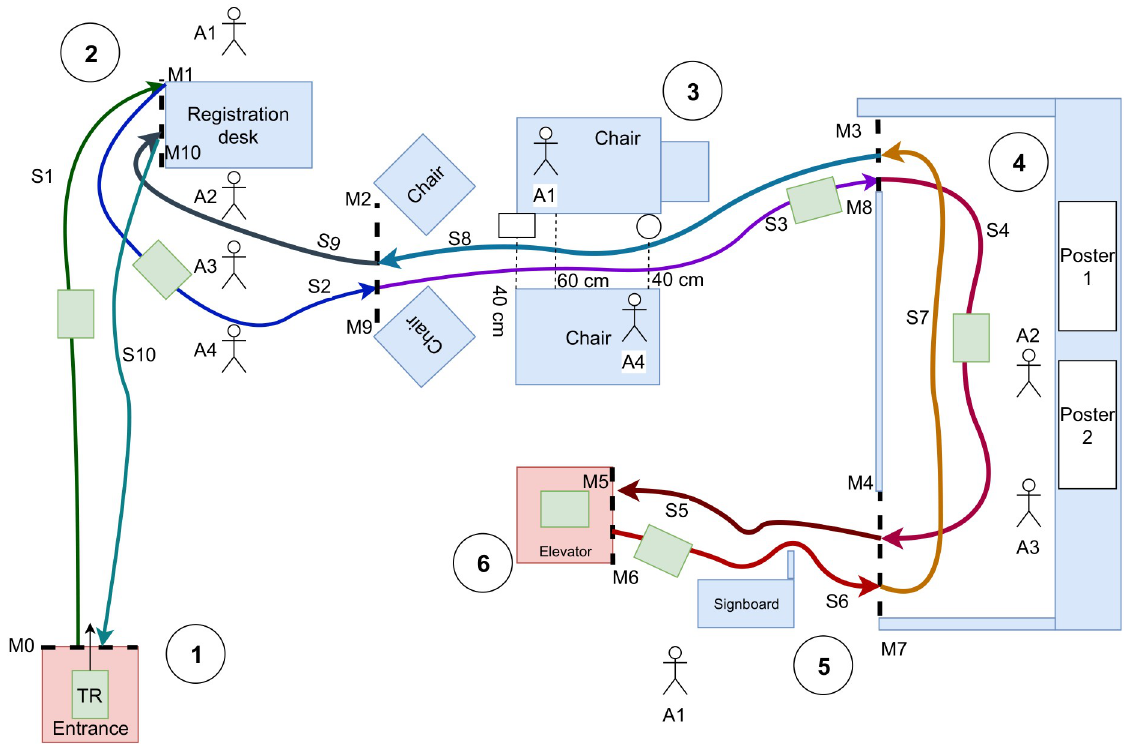
Fig 16. Top down schematic view of the layout for study 2. 1) Entrance and starting point of the experiment 2) registration desk 3) small corridor, 4) poster presentation hall 5) signboard 6) elevator).